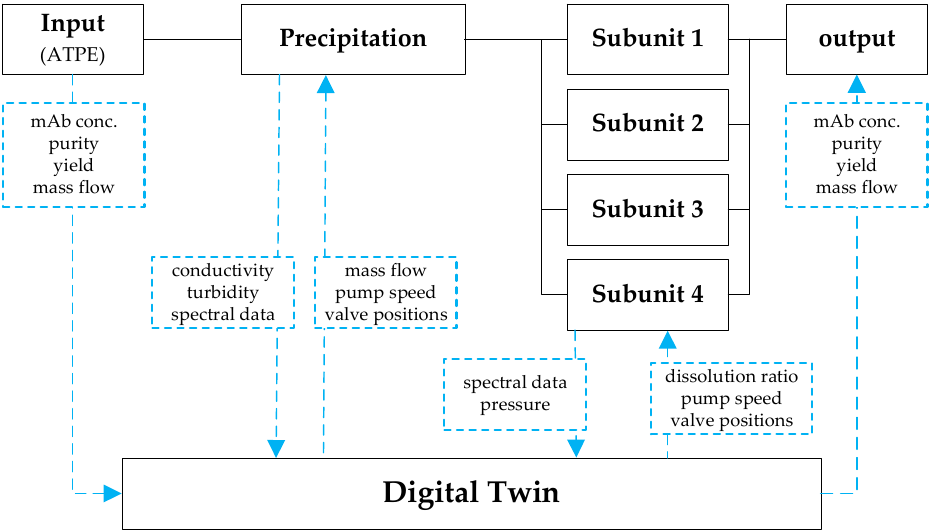
Figure 20. Simplified illustration of proposed advanced process control (APC) for the precipitation unit. Precipitation tanks are merged into one tank. Therefore, subunits mean the filter modules.